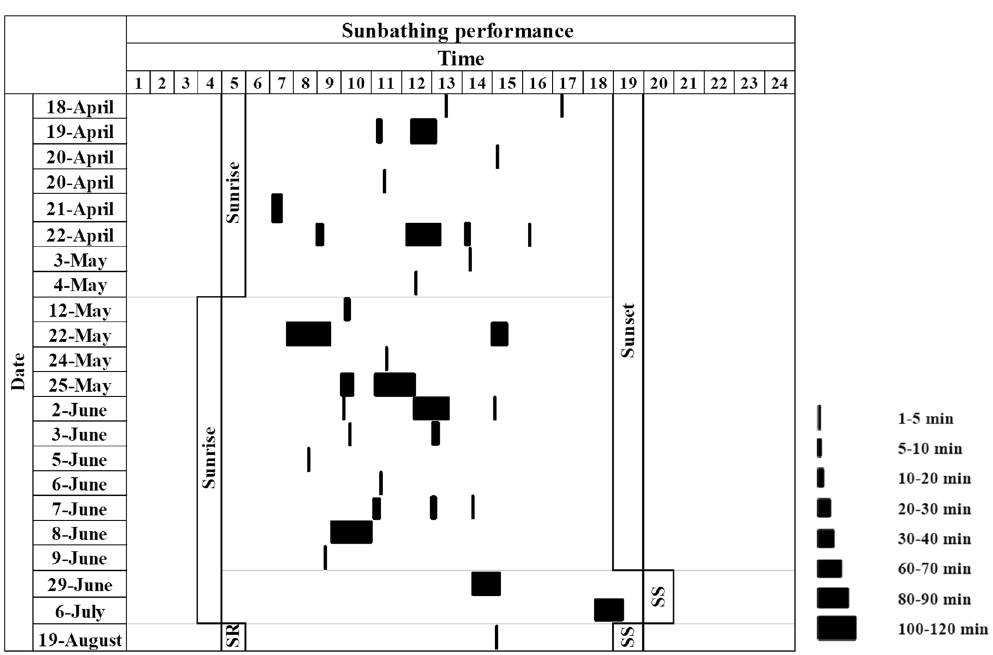
Figure 7. Graphical representation of the length of sunbathing episodes recorded. For each sunbathing episode the date, the hour, the duration (min), the time of sunset (SS) and sunrise (SR) was